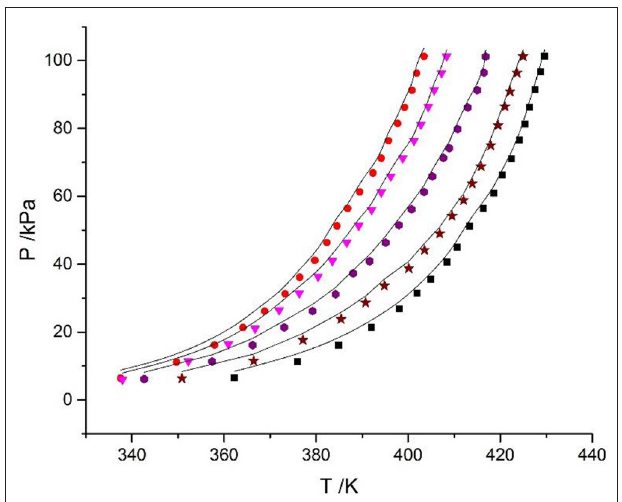
FIGURE 7 | Prediction of experimental VLE data for the LiBr + CaCl 2 + H 2 O system. Symbols ( , ma = 21.05 mol/kg, mb = 0 mol/kg; , ma = 1.5